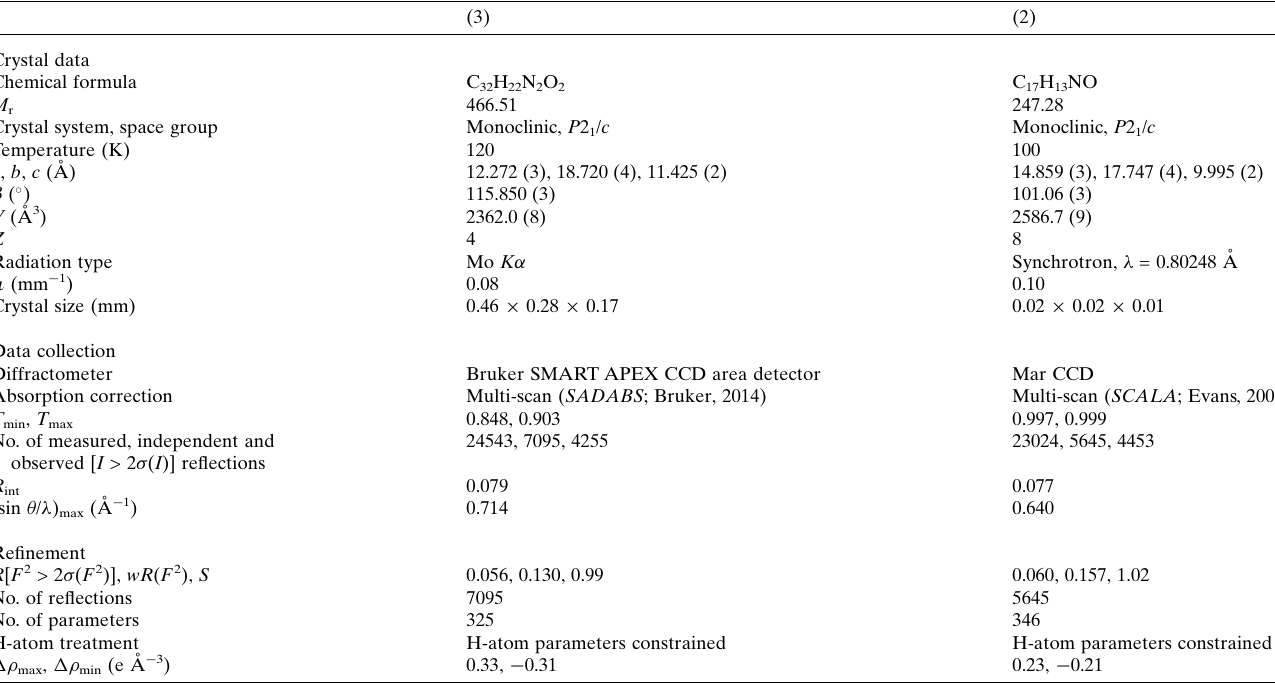
Crystal data Chemical